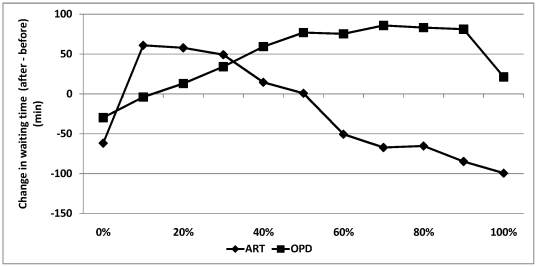
Impact of ART to OPD patient ratio on difference in waiting times before and after integration.Positive numbers denote an increase in waiting time whereas negative numbers indicate a reduction in waiting time due to integration. Zero denotes that the waiting times before and after integration are equal.